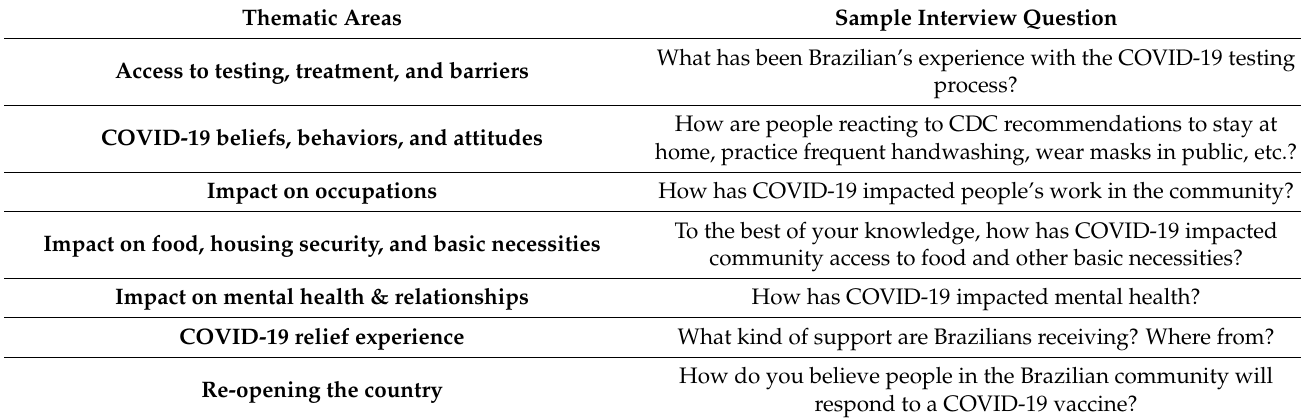
Table A1. Thematic Areas and Questions for Key Informant